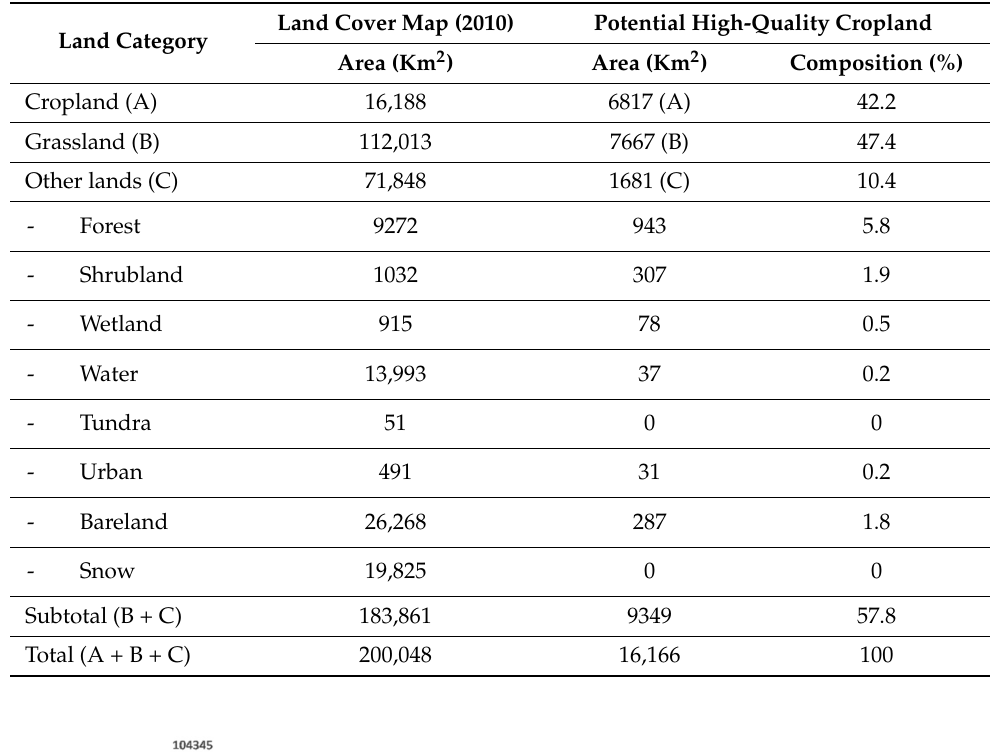
Table 3. Composition of potential high-quality cropland by land use categories.